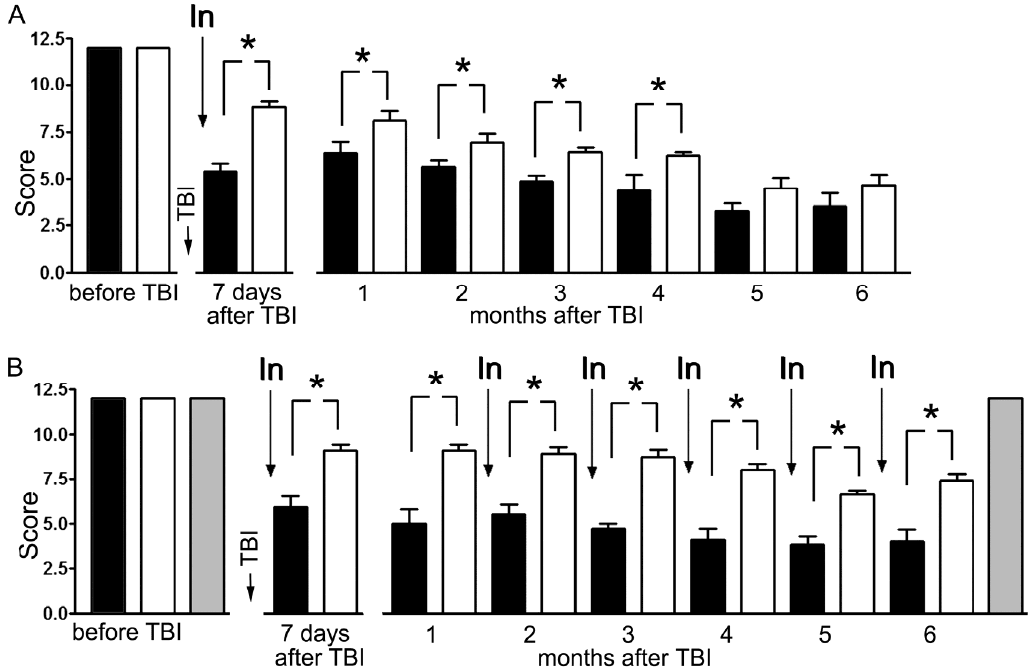
Figure 1. E ff ect of methylene blue (MB) on the neurological deficit in the right limbs caused by traumatic brain injury (TBI) of the left sensorimotor cortex. The “limb-placing test”. ( A ) A single administration of MB 30 min after the injury; ( B ) administration of methylene blue 30 min after the injury and then monthly (6 injections in total). Animals treated with saline solution after the trauma (black columns), animals treated with methylene blue after the trauma (white columns), sham-operated animals (grey columns). Injection of methylene blue or saline solution (In). * p <